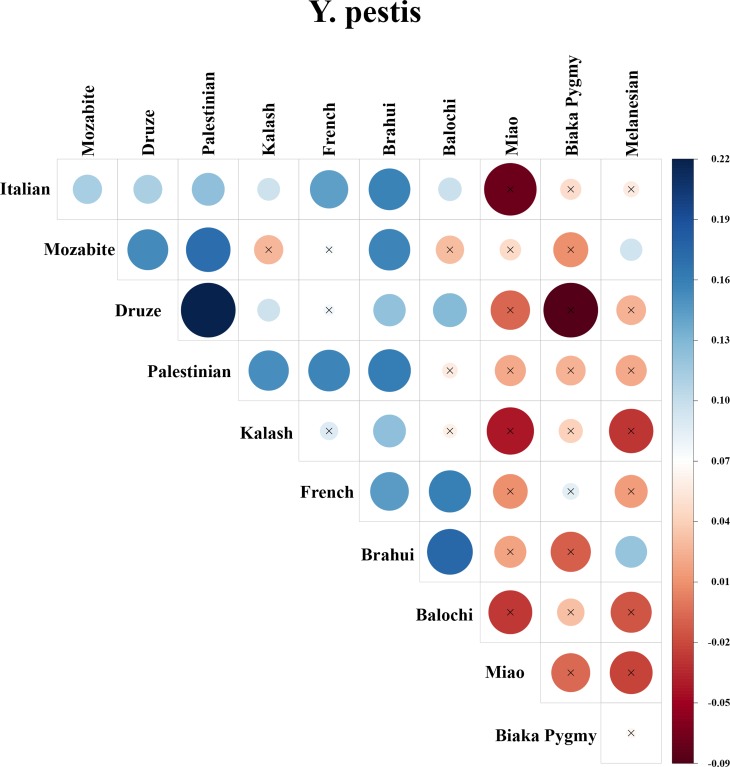
Overlap of selection targets associated with Yersinia pestis.Each population was associated with a positive selection score for each gene interacting with Yersinia pestis. There was significant overlap in the genes undergoing selection across both populations in many populations. We performed pairwise correlations among the 11 most selected populations to uncover the extent of overlap in selection targets. Kendall’s’ Tau-b coefficient ranged from -0.09 to 0.22. We identified 23 population pairs with significantly correlated positive selection scores (a positive selection score is produced for each gene).